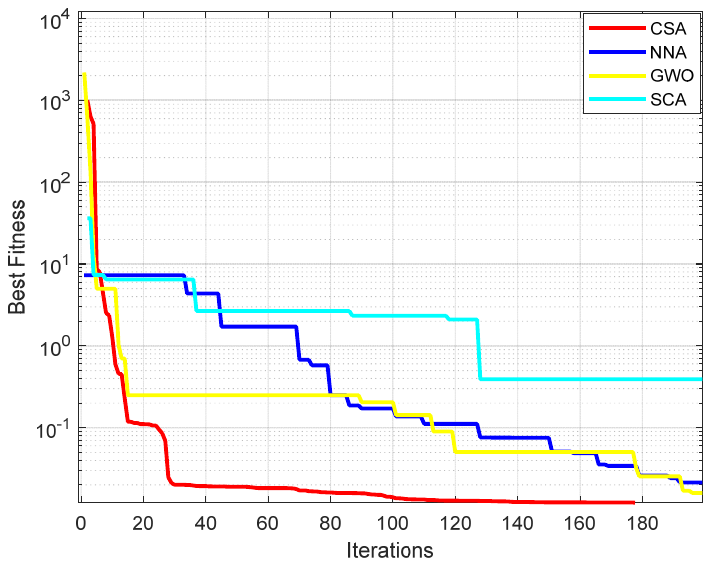
Figure 8. Characteristics of Ballard stack under various pressures: ( a ) current-voltage and ( b ) cur- rent-power.